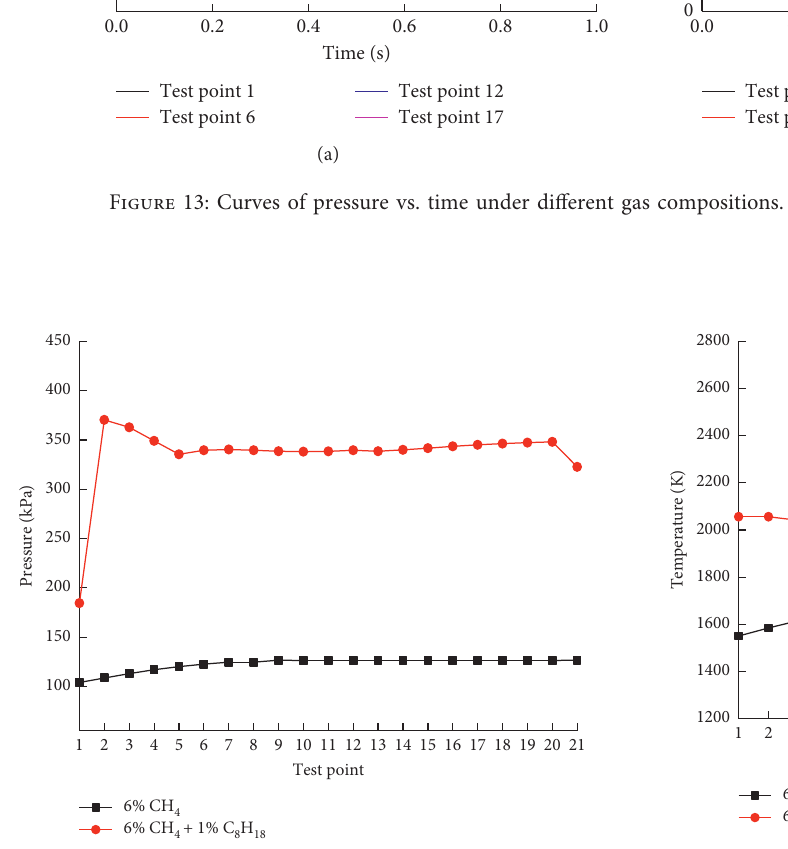
Figure 14: Curves of peak pressure under different gas compositions.